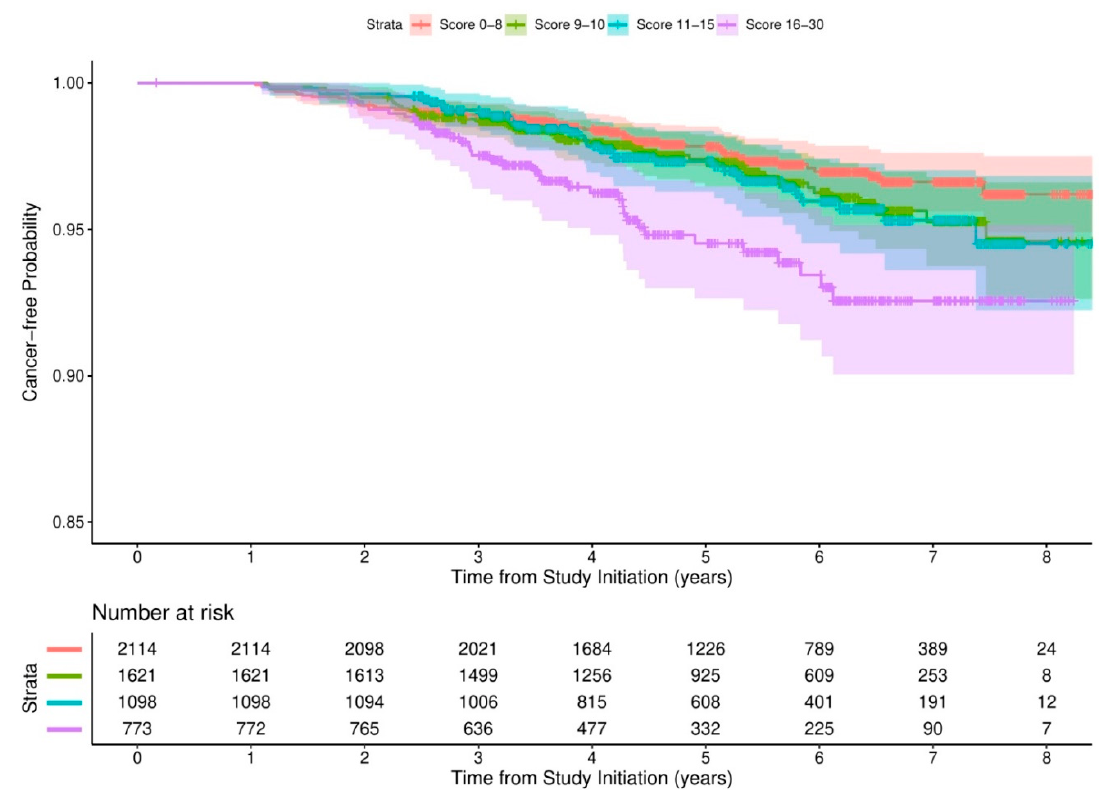
Figure 3. Kaplan–Meier estimates of cancer-free probability by comorbidity risk scores.